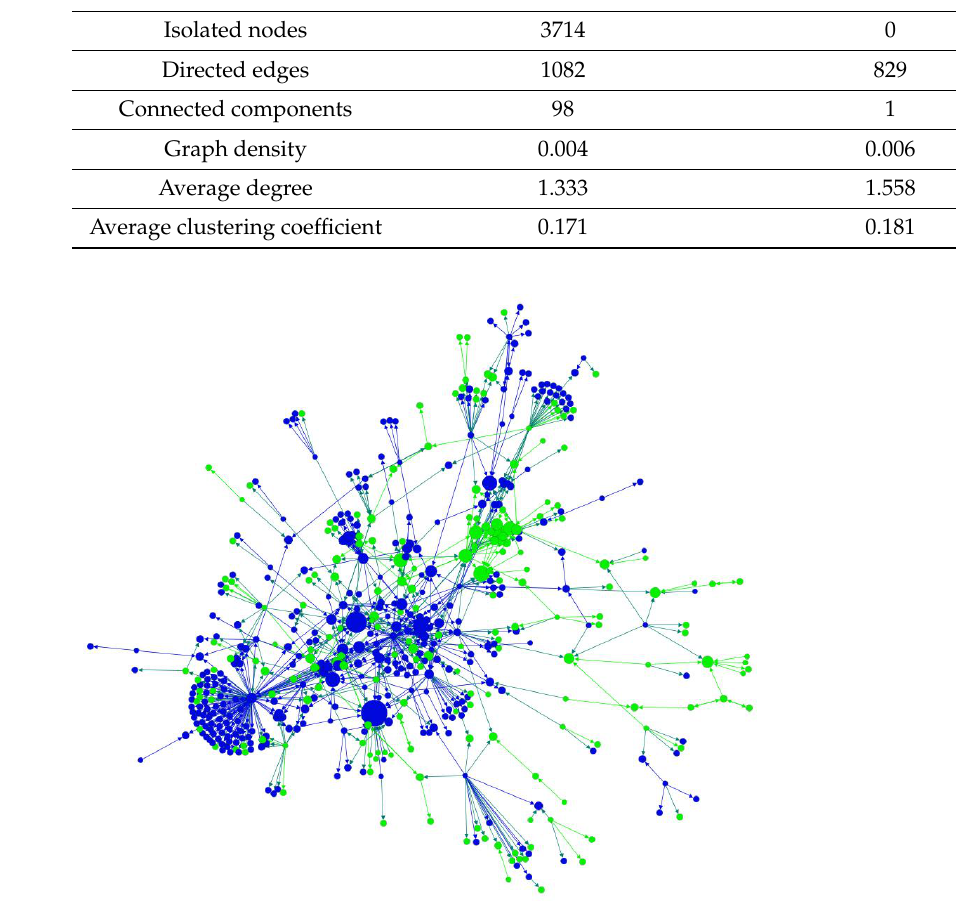
Figure 1. The largest component of the network of Instagram accounts with #IQOS post(s) between 1 January 2021 and 5 April 2021. (Each node represented an account who had post(s) with the hashtag #IQOS on Instagram during the study period. Each directed edge represented the following relationship between two nodes. Blue nodes referred to business accounts authorized by Instagram and green nodes referred to personal accounts. The size of each node represents the level of in- degree of that node). To investigate nodes that were positioned more centrally within the network, we identified the top five nodes for each of the four common centrality measures (i.e., in- degree, out-degree, betweenness, and closeness) (Table 3). We found that for nodes with